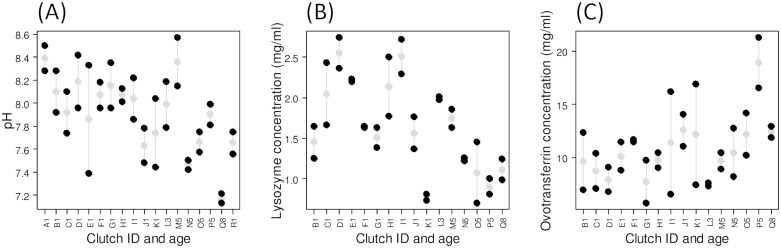
Repeatability of albumen antimicrobials among and within clutches.Clutch ID is given by a letter and followed by its age (LetterNumber), and is consistent across plots. Clutch age corresponds to the number of days that the complete clutch spent in the nest; day 1 is the day of clutch completion. Only complete nests (i.e containing two eggs) are plotted and ordered by clutch age. Within each plot, one clutch is represented by the values of its two eggs (black dots) and by their mean value (±S.E.) (grey dots with error-bars). Clutches are ordered by age, the youngest starting on the left part of the graphs. (A) pH, (B) lysozyme and (C) ovotransferrin concentrations.